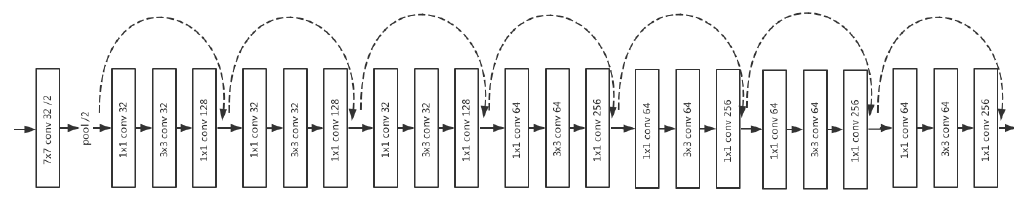
Figure 3. Modified Resnet-50 feature